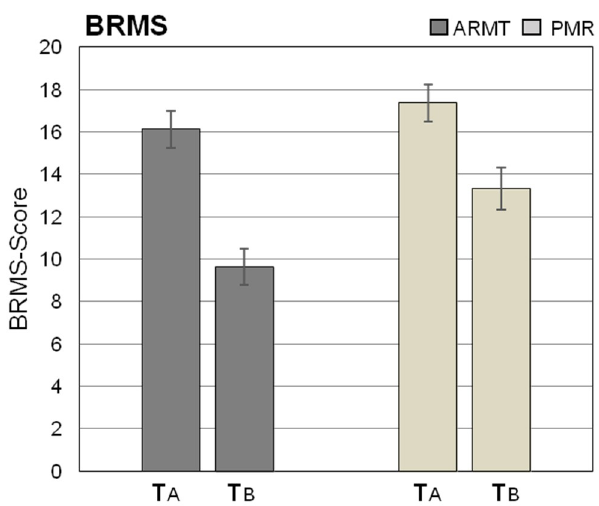
Figure 3. Summed up Bech–Rafaelsen Melancholia Scale (BRMS) scores in ARMT and PMR groups before ( T A) and after ( T B) completing the full series of treatments (mean ± SEM).